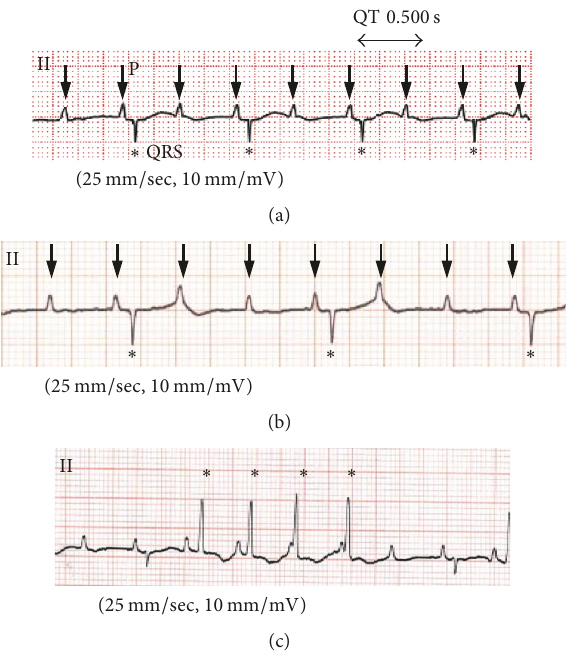
Figure 2: Electrocardiograms recorded after birth (arrows: P wave; asterisk: QRS complex). (a) Severe bradycardia (HR 60–70 bpm), 2 :1 AVB, and QT interval prolongation. (b) Transient 3 :1 AVB. (c) Nonsustained ventricular